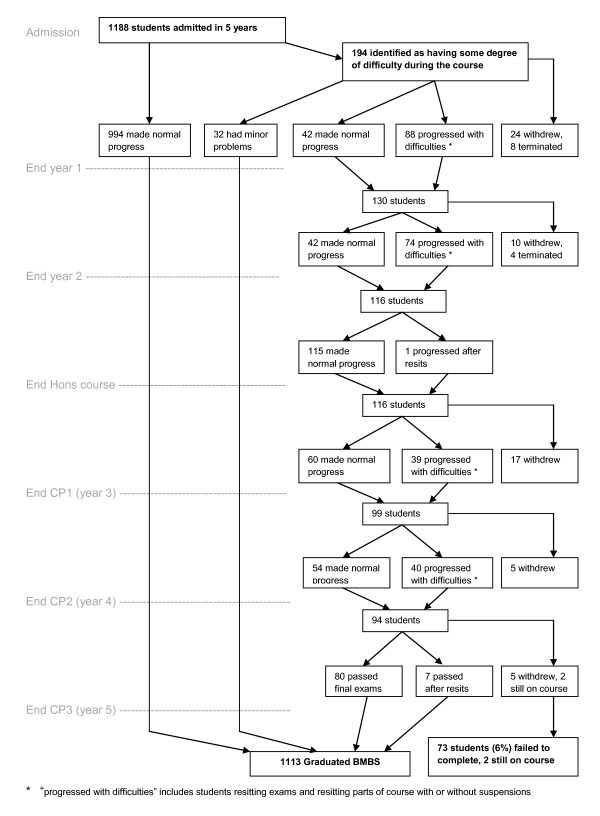
Summary of course progress and attrition on the 5-year undergraduate medical course.